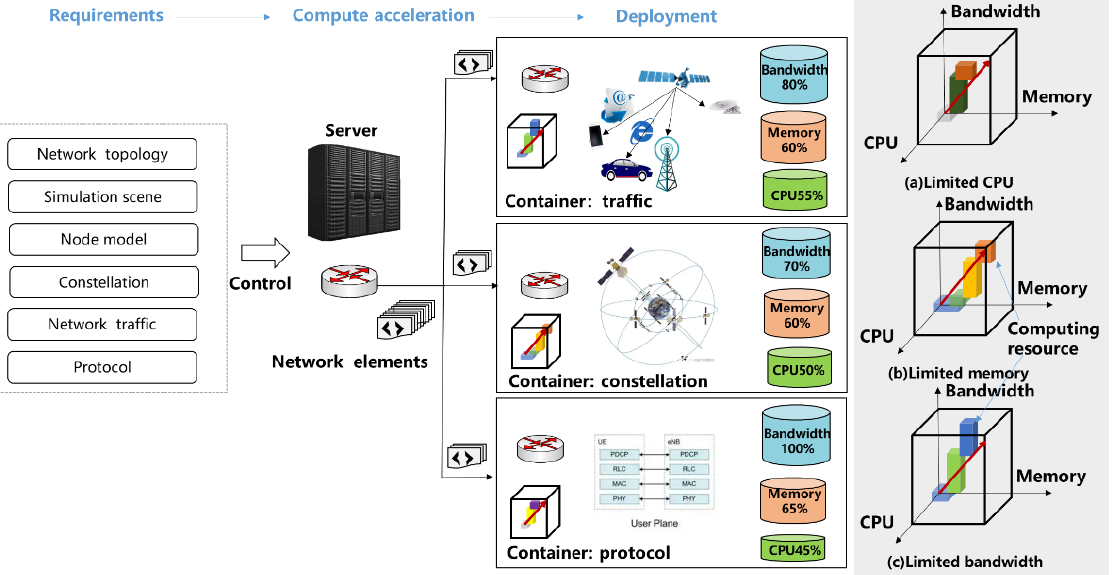
Figure 3. Function–resource three-dimensional packing model.